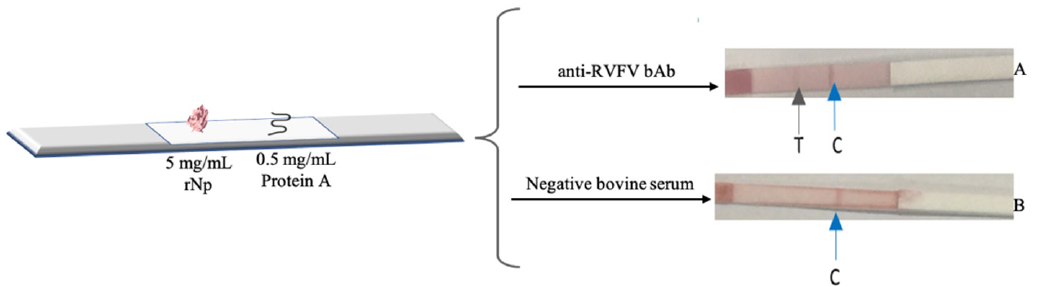
Figure 7. The liquid-test results on the investigation of the RVFV positive ( A ) and negative ( B ) sera. The black and blue arrows denote the test and control line, respectively.